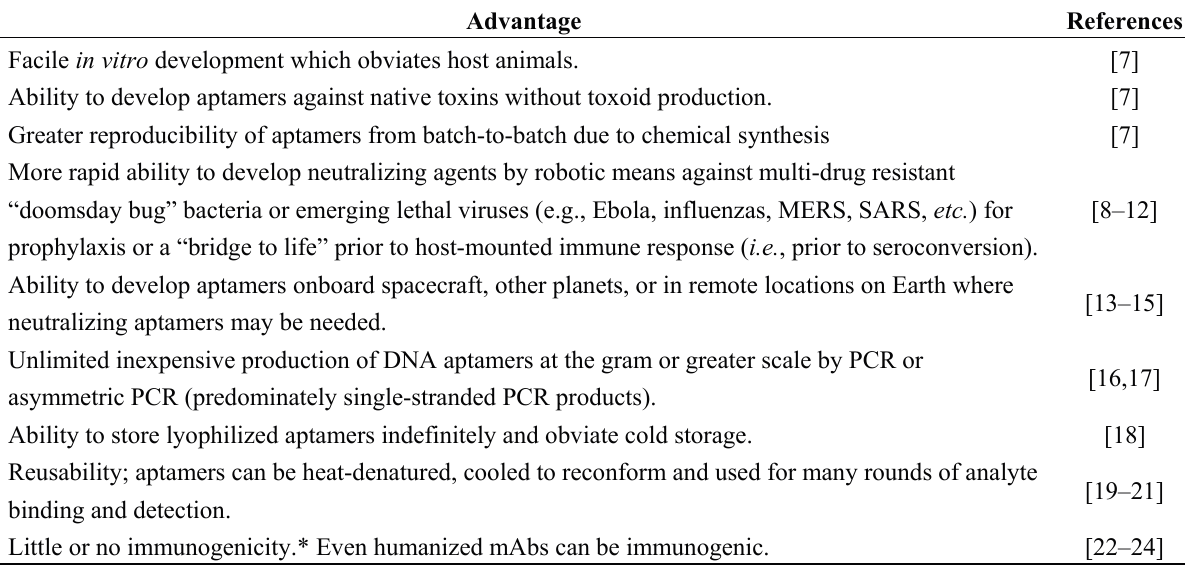
Table 1. Key Advantages of Aptamers vs. Antibodies with Supportive